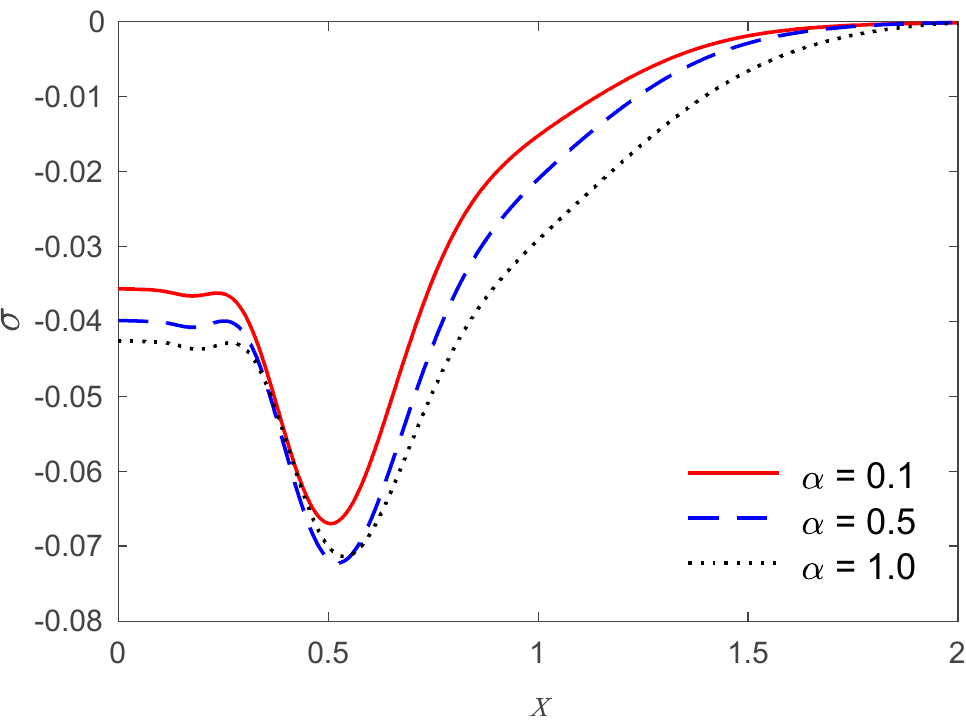
Figure 5. The stress of fluid variation 𝜎 via 𝑥 for three values of fractional parameter.